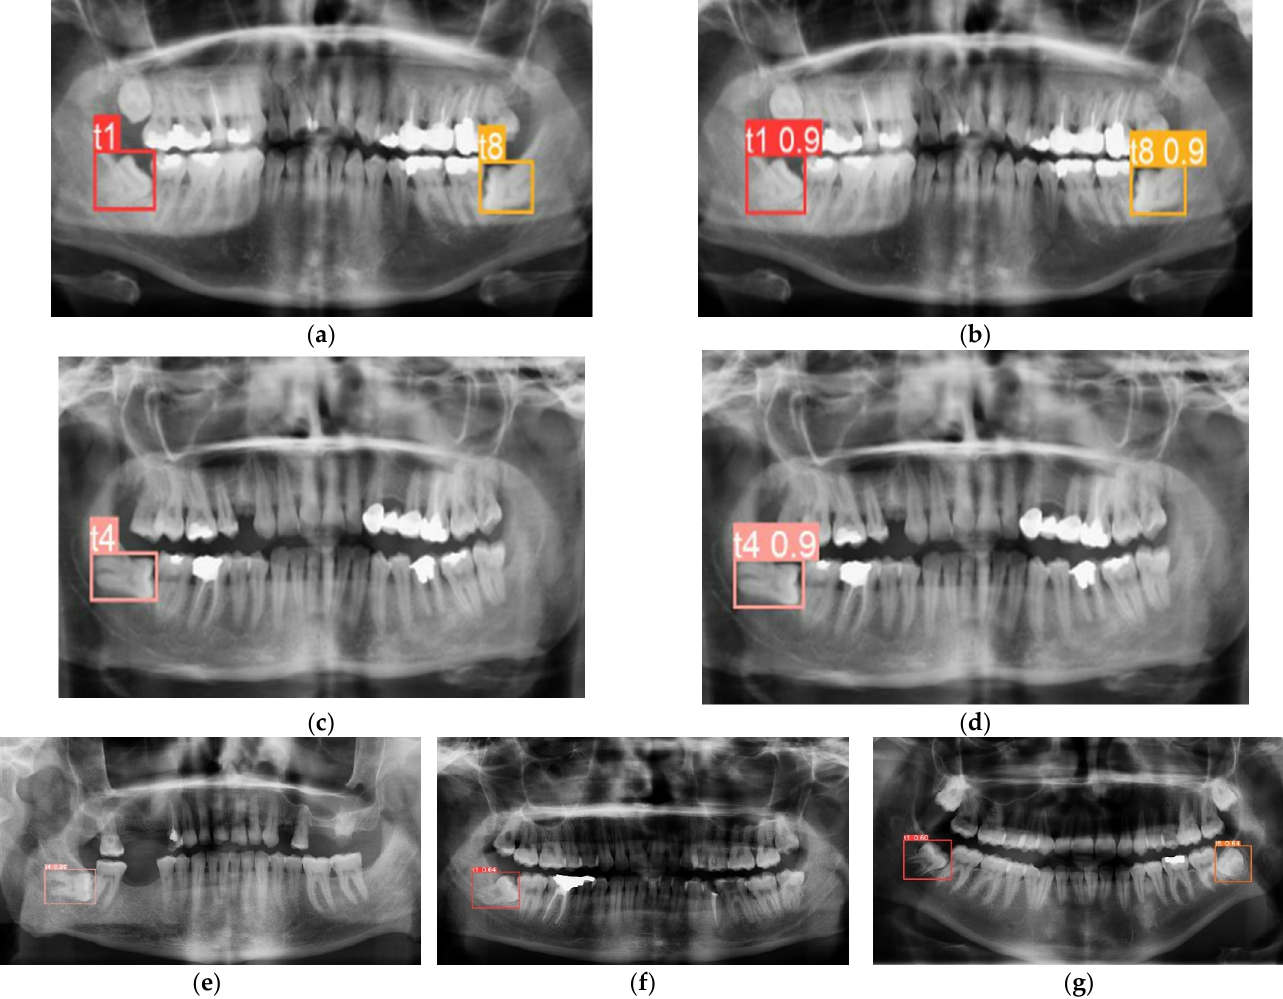
Figure 6. Detection result samples from YOLOv3 ( a – d ), ground truths ( a – c ), predictions ( b – d ) and Faster RCNN with ResNet ( e ), AlexNet ( f ) and VGG16 ( g ).